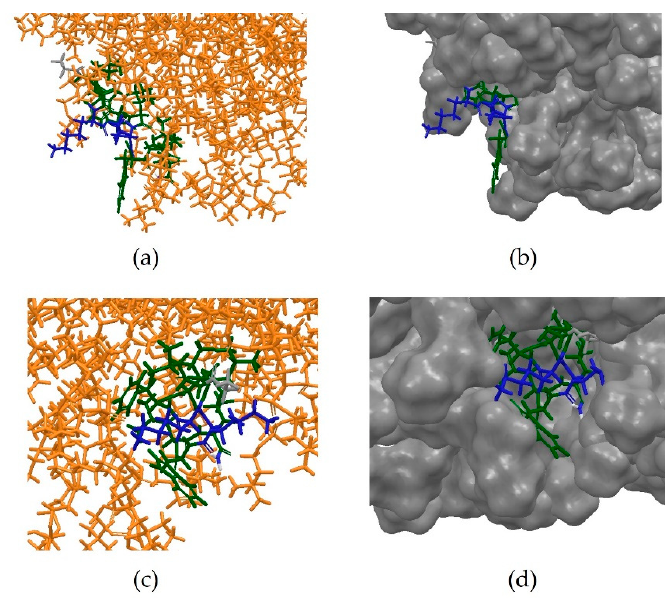
Figure 11. ( a ) Initial frame of the MD simulation of the PDB entry 2MJT; ( b ) Anoplin embedded in the micelle at the beginning of the MD simulations; ( c ) Final frame of the MD simulations; ( d ) Anoplin remains embedded into the micelle at the end of the simulation, showing that this system is stable under the conditions used. The residues have been coloured according to their properties, with positively-charged amino acids in blue, hydrophobic in green, neutral in grey and polar uncharged in cyan. It can be observed that Anoplin maintains an amphipathic conformation throughout the simulation.